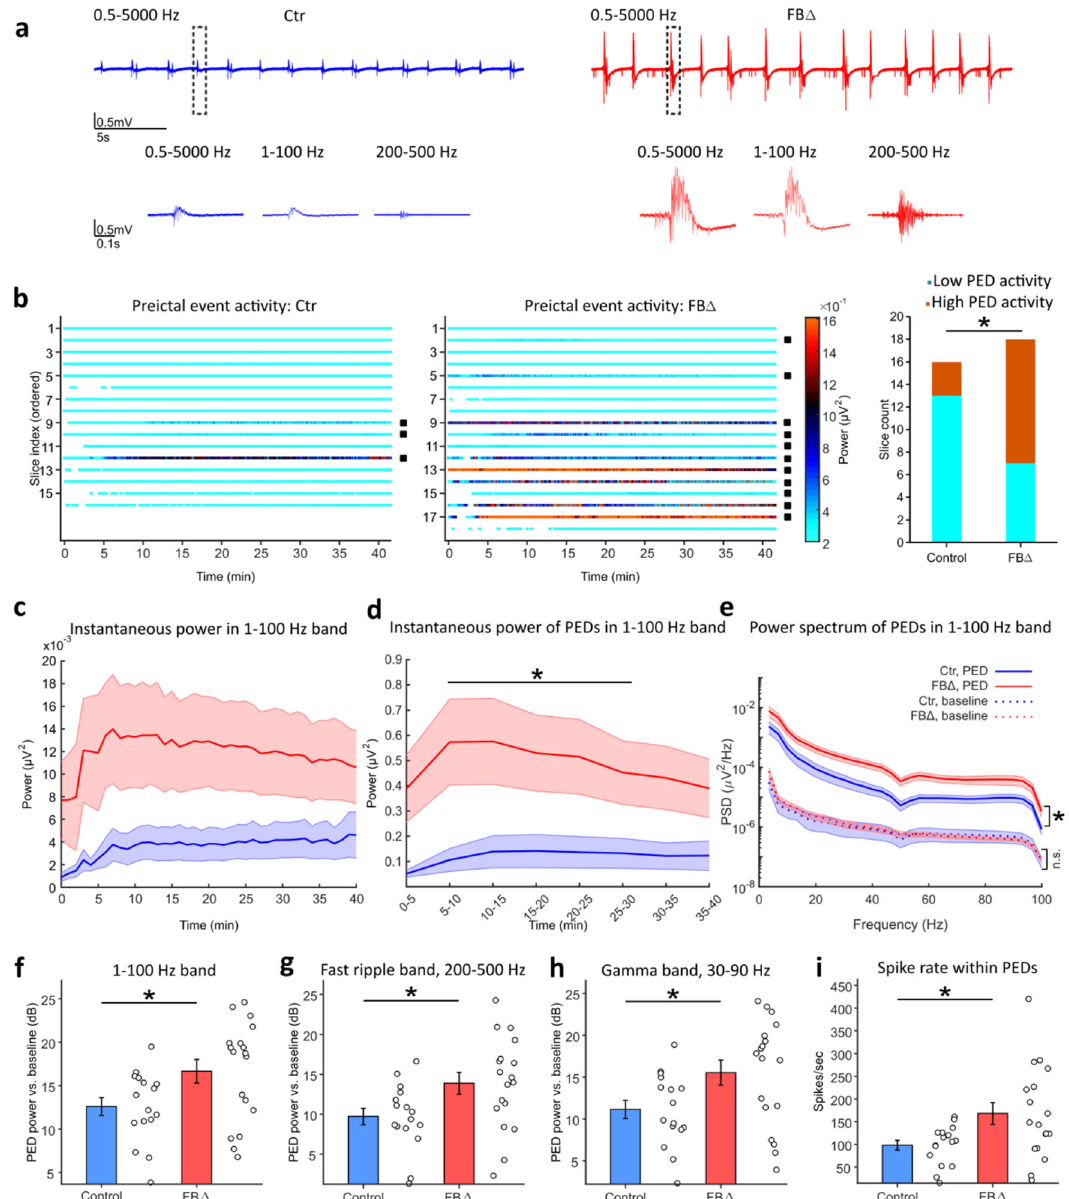
Fig. 4 The CA3 region is susceptible to epileptiform activity in the ATR-deleted hippocampus. a Deletion of ATR increases the amplitude of the preictal epileptiform discharges (PEDs). Example 30-second sections of 40-minute extracellular fi eld potential recordings of PEDs in CA3. Zoom-in representative PEDs (0.5 – 5000 Hz) in population fi eld activity band (PFA, 1 – 100 Hz) and fast ripple activity band (FRA, 200 – 500 Hz). b PEDs show higher instantaneous power in ATR-FB Δ (FB Δ ) CA3 slices compared to controls (Ctr). Color-coded raster plots of the PED timing in all recorded slices. Colors represent the maximum instantaneous power of each PED in 1 – 100 Hz band. The slices are arranged in descending order, by the fi rst slice having the highest number of detected PEDs. The slices containing PEDs with a power-level beyond 0.4 µ V 2 (high-activity PEDs) are designated with a black square next to them. The ratio of slices with high-activity versus those with low-activity PED instantaneous power is increased after ATR deletion (right panel); Chi-square test (one- tailed), p = 0.012. c The instantaneous power of the whole fi eld potential signal in 1 – 100 Hz band, computed within non-overlapping 1-min bins. The mean (solid line) ± SEM (shaded area). d Same as ( c ), but only for isolated PEDs (peak values) within 5-min bins. A one-tailed permutation test method of Cohen is used to compare the results of the two groups at each bin, with p < 0.05 (see Methods). e ATR-deletion leads to an increase in the power spectrum of PEDs over 1 – 100 Hz band. Power spectral density (PSD) of the PED events (solid lines), together with that of the baseline (i.e. non-PED epochs; dotted lines). f The summed baseline-normalized power presents an increase in the power of PEDs over 1 – 100 Hz shown in ( e ). Data presented as mean ± SEM. g ATR-deletion induces stronger fast ripples within PEDs. Same as ( f ), but for the fast ripple band (200 – 500 Hz). h Same as ( f ), but for the gamma band (30 – 90 Hz). i ATR-deletion increases the rate of spikes within PEDs, as detected in the multiple unit activity signal (MUA, > 500 Hz). Data are obtained from 16 slices of 4 control and 18 slices of 4 ATR-FB Δ mice and presented as mean ± SEM. Two-tailed t -test for ( e – i ): p = 0.026 for ( e ) and ( f ), p = 0.023 for ( g ), p = 0.027 for ( h ), and p = 0.016 for ( i ). * p < 0.05. Source data are provided as a Source Data fi